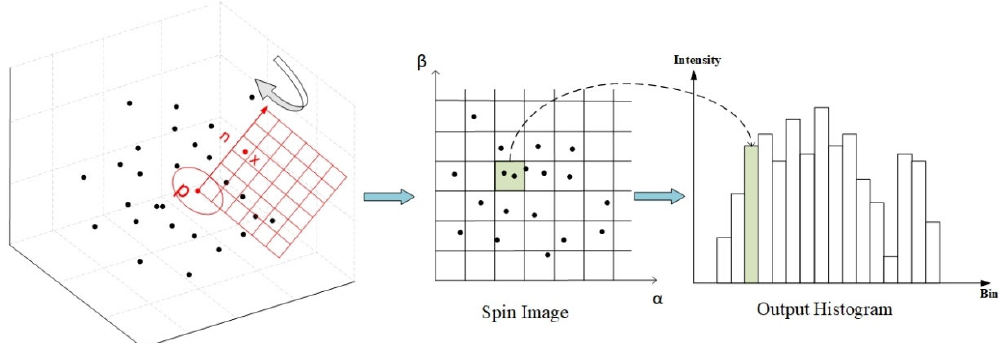
Figure 4. Generation principle of the spin image approach.